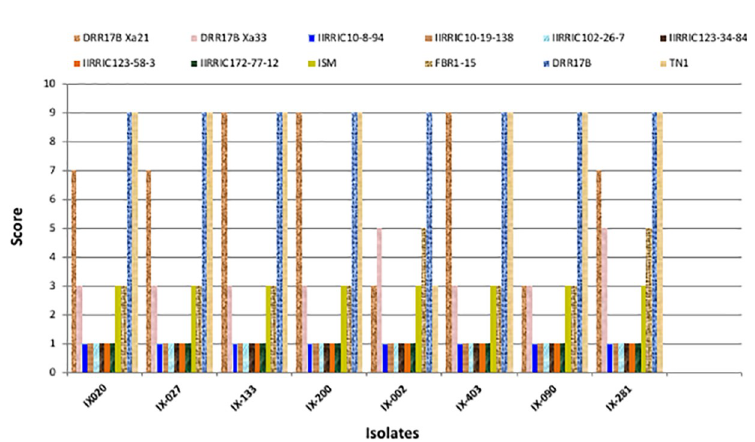
Fig 4. Screening of the single-gene and two-gene pyramid lines of DRR17B against different virulent isolates of the bacterial blight pathogen. Eight selected ICF 4 of DRR17B possessing either Xa21 ( IIRRGP3-87-64-22-4-50) or Xa33 (IIRRGP22-73-10-15-13-2) or Xa21 + Xa33 (# IIRRIC10-8-94, IIRRIC10-19-138, IIRRIC102-26-7, IIRRIC123- 34-84, IIRRIC123-58-3, and IIRRIC172-77-12) were screened for their BB resistance with eight virulent isolates of Xanthomonas oryzae pv. Oryzae ( Xoo ) along with the recurrent parent (DRR17B) and donor parents (‘ ISM ’ and FBR1- 15). While all the lines showed excellent resistance against the multiple isolates of Xoo screened, the two-gene pyramid lines (i.e., Xa21 + Xa33 ) were observed to show a higher level of resistance to the different isolates of the pathogen.